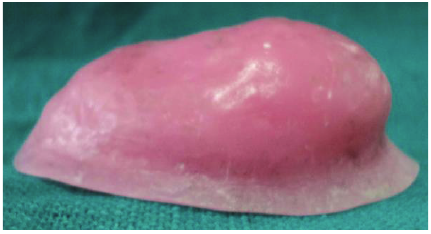
Figure 11: Lateral view of bulb.